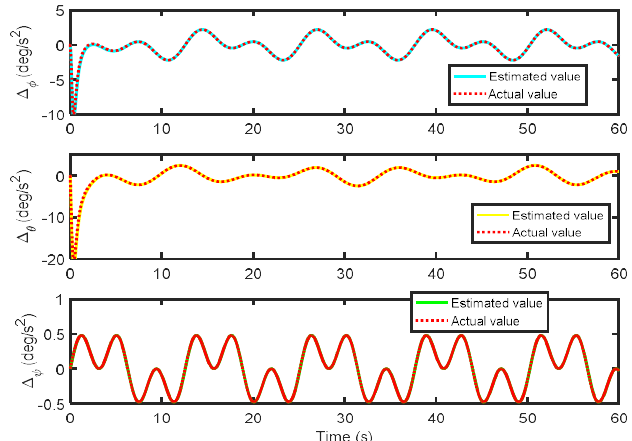
Figure 4. Estimation results for lumped disturbances using USDE.